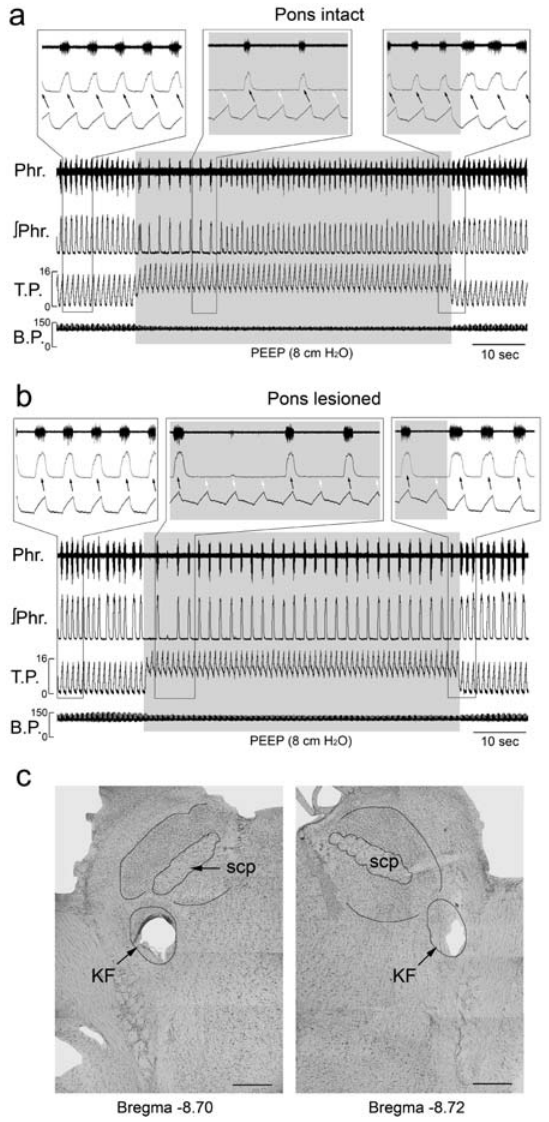
Figure 1. Disruption of respiratory-ventilator entrainment by positive end-expiratory pressure (PEEP) and its adaptation via nonassociative learning in a vagi-intact animal (a) before, and (b) after bilateral lesions at the dorsolateral pons. Phr, phrenic nerve discharge; # Phr, integrated phrenic signal; T.P., tracheal pressure (cm H 2 O) at 60 cpm; B.P., arterial blood pressure (mm Hg). Insets show expanded views of selected breaths. ( c ) Photomicrographs showing extent of lesions covering almost the entire Ko¨lliker-Fuse (KF) nucleus at the left side and the ventrolateral part of this nucleus at the right side. scp, superior cerebellar peduncle. Bar: 0.5